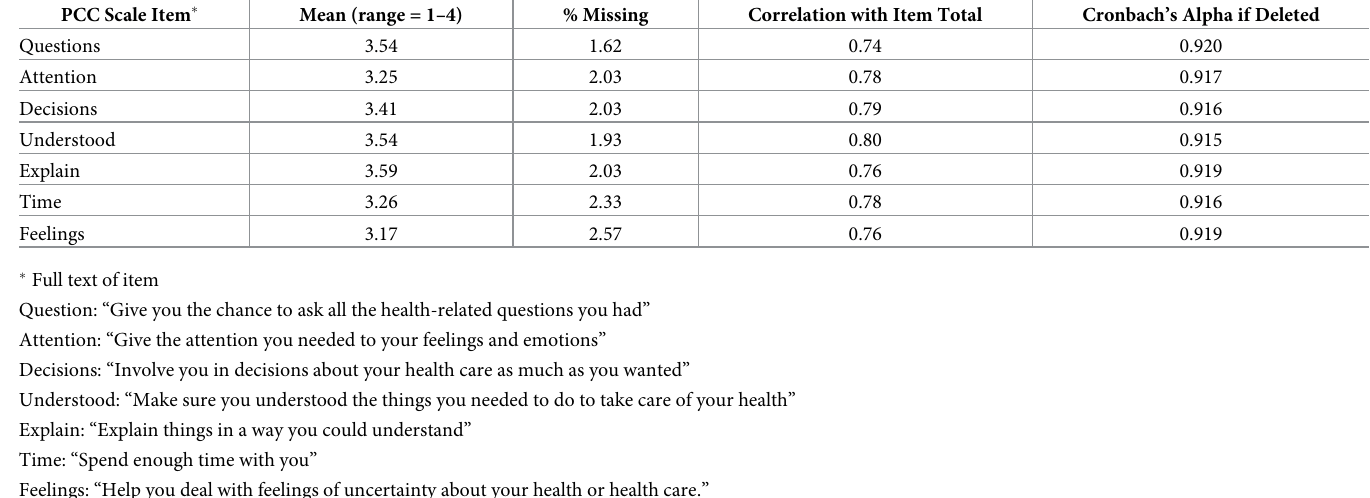
Table 2. PCC scale items, means, % missing, standardized variables item/total correlations and alpha if item deleted. PCC Scale Item �